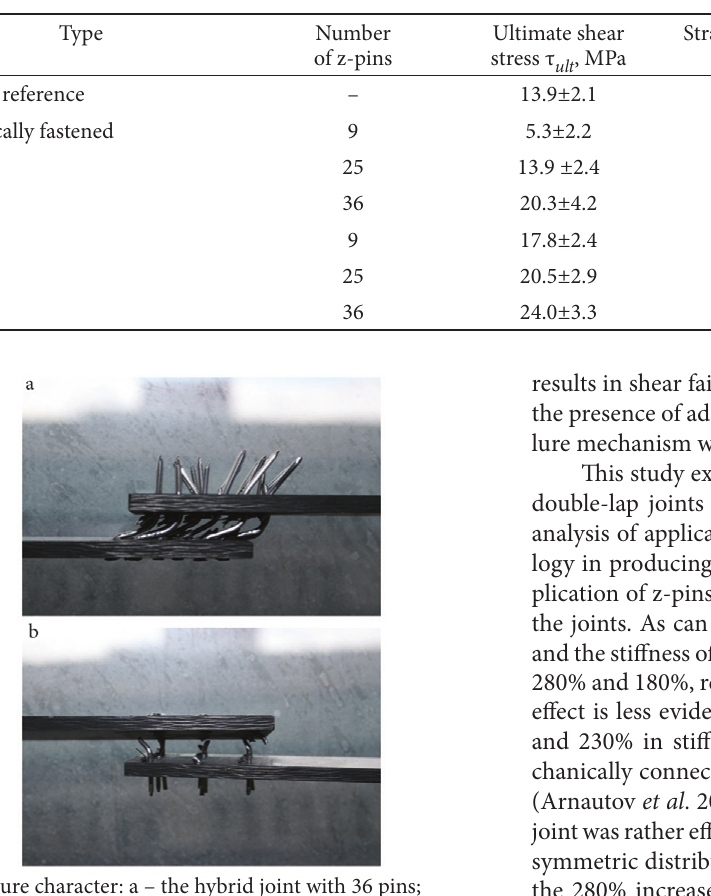
Table 1. Main characteristics of the single-lap joints